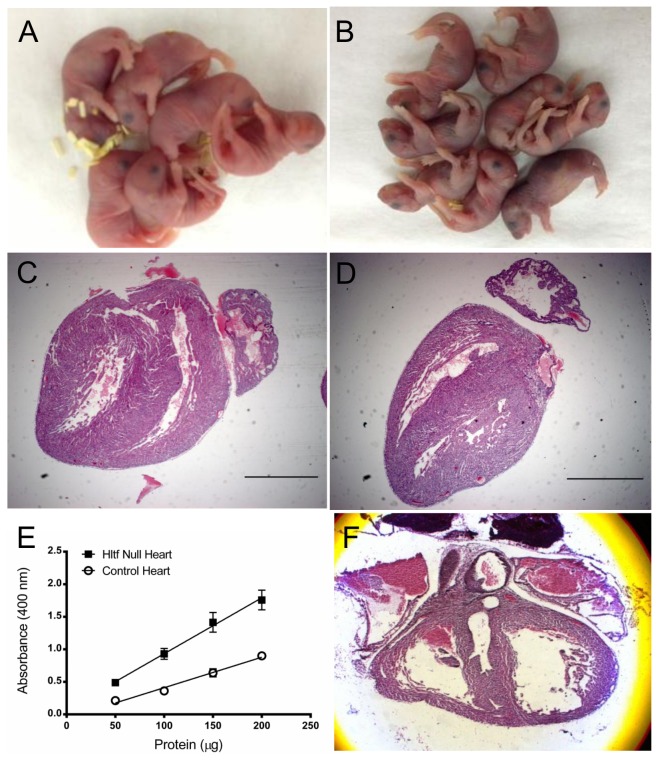
Hltf null phenotype compared with controls at 6-8 hours postpartum.Compared with controls (A), Hltf null pups developed cyanosis (B). Deviation in heart shape between control (C) and Hltf null mice (D) are evident in H & E stained sections. Increased (p<0.0001) active caspase 3 (E) showed elevated apoptosis in Hltf null hearts. One of five null pups had a rare left coronary artery fistula (F).